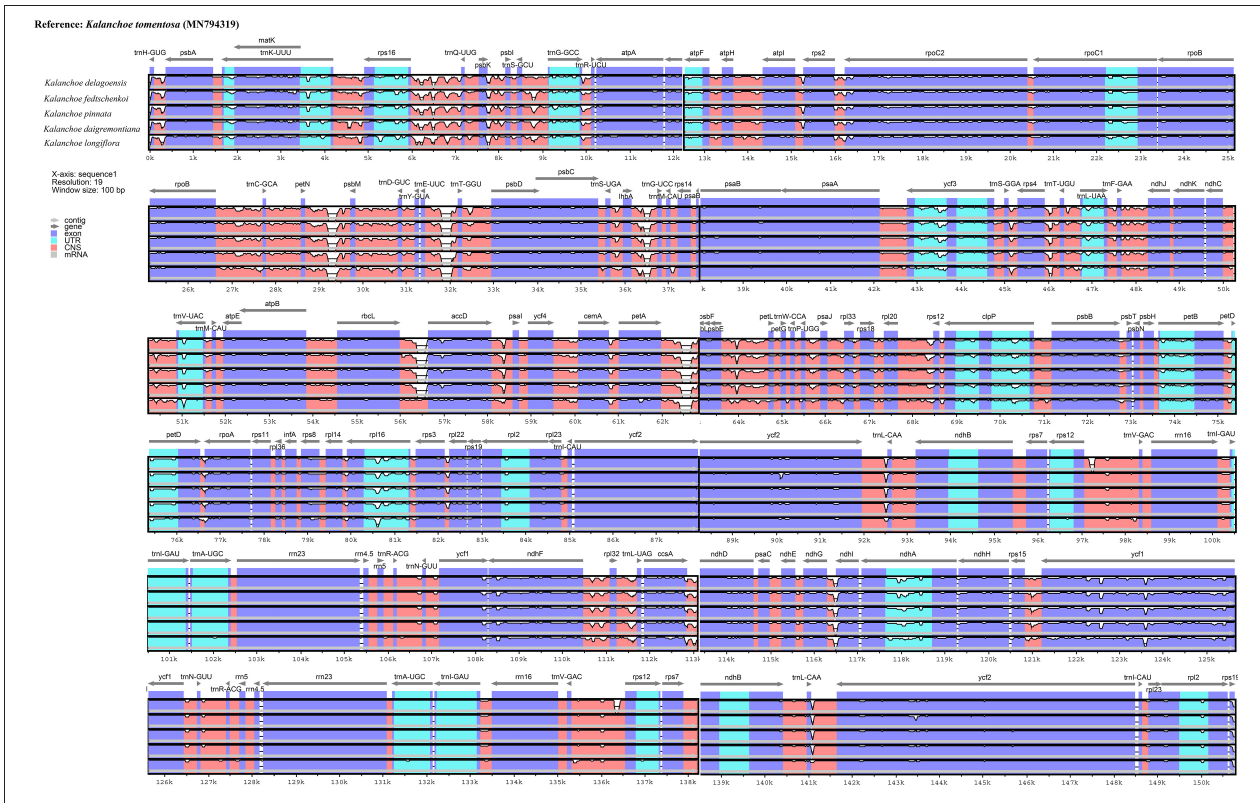
FIGURE 4 | Sequence identity plot comparing the five plastomes using mVista with Kalanchoe tomentosa (Accession no. MN794319) as a reference. The y -axis corresponds to percentage identity (50–100%), while the x -axis shows the position of each region within the locus. Arrows indicate the transcription of annotated genes in the reference genome.